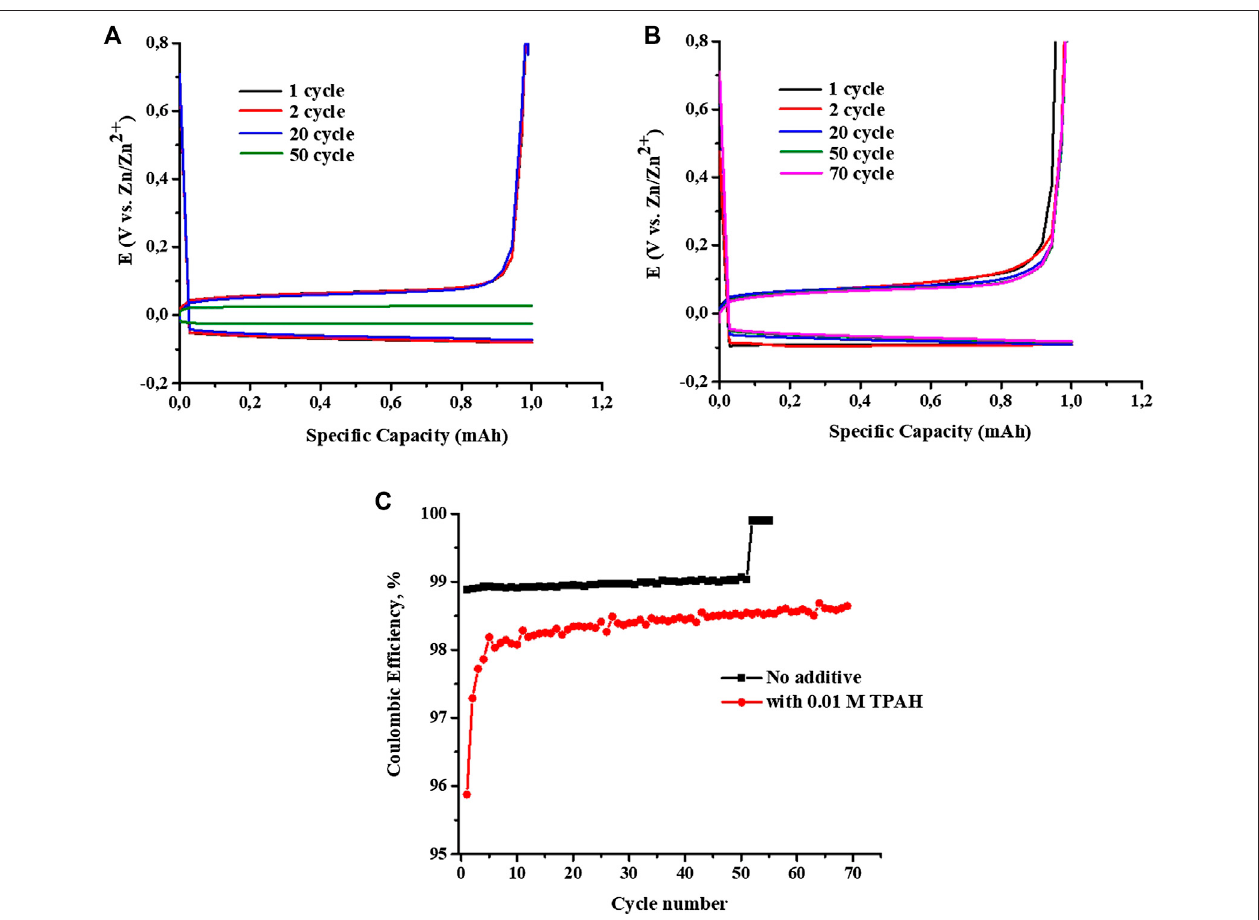
FIGURE 3 | Charge/discharge curves of Zn//ZnCl 2 +LiCl//Cu beaker cell (A) without and (B) with 0.01 M TPAH electrolyte additive, and (C) the cyclability of cells with and without TPAH additive at 20 mA cm − 2 .